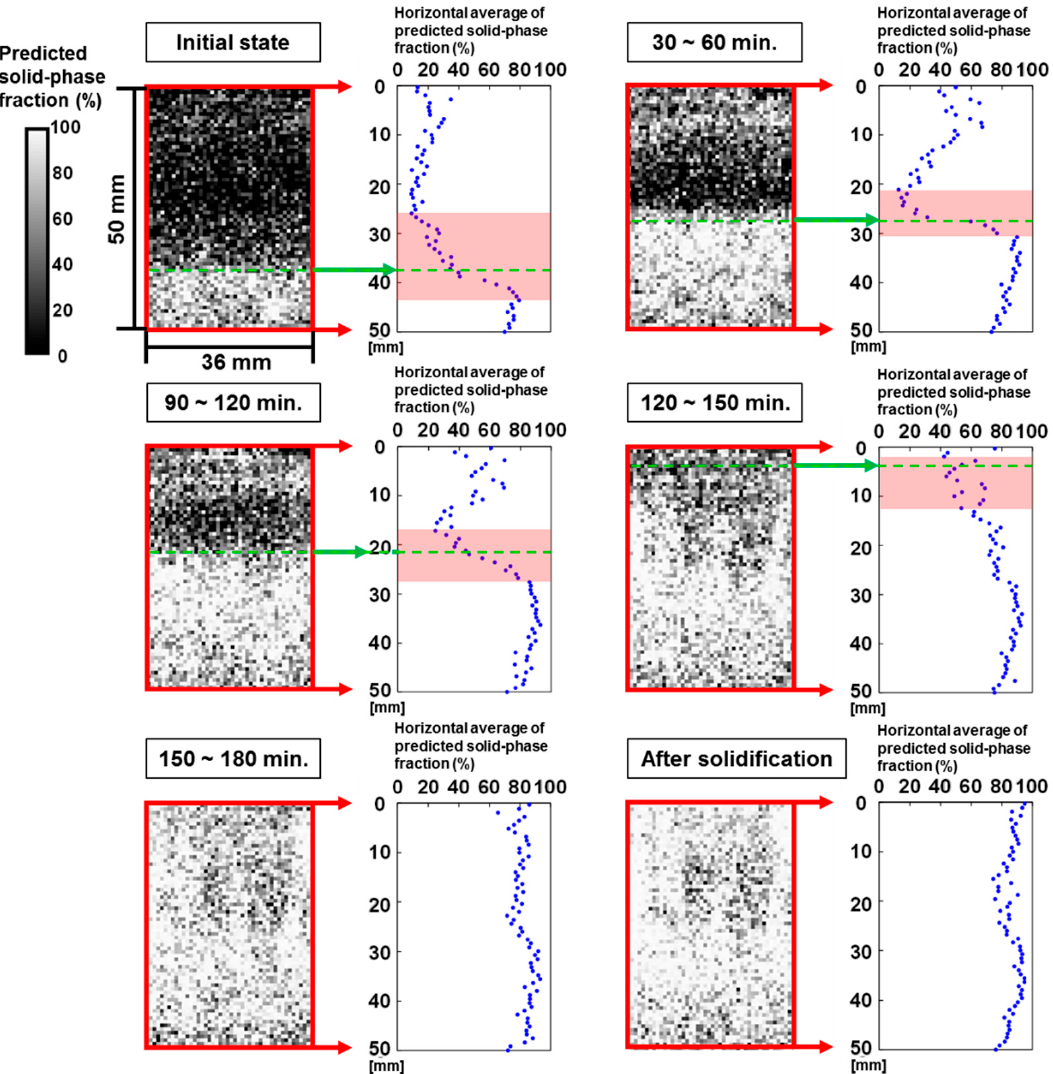
Figure 14. Results of solid-phase fraction imaging during the solidification. For each time period, the left figure shows the mapped real-space distribution of the solid-phase fraction and the right figure shows its horizontal average. On the right, the colored area indicates the location of the solid–liquid coexistence zone, while the green line indicates the interface location estimated by linear fitting where the solid-phase was 50%.